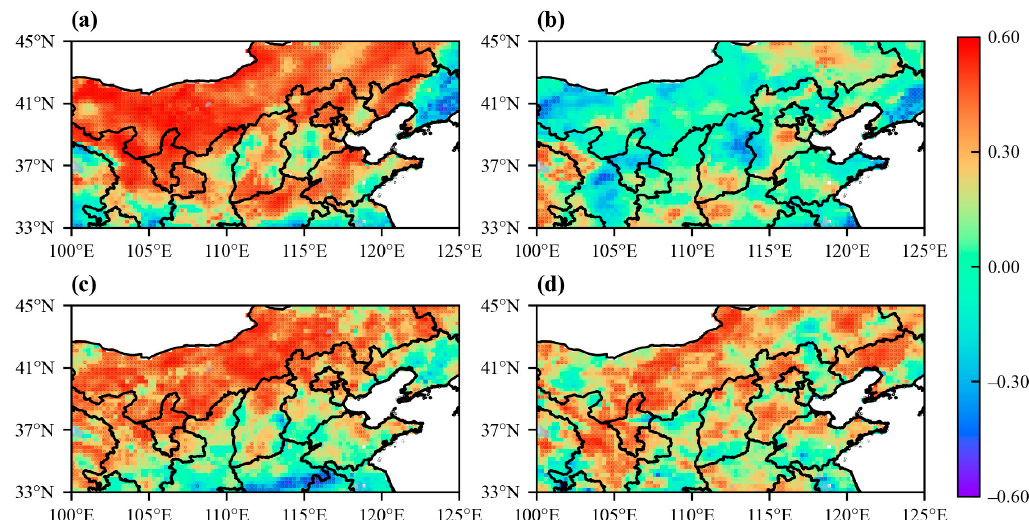
Figure 6. Decadal changes in spatial distribution of evapotranspiration–precipitation coupling in the climate transitional zone of northern China, ( a ) for 1980–1989, ( b ) for 1990–2000, ( c ) for 2000– 2009, and ( d ) for 2010–2019 (dot denotes CS passing 0.05 significance test).